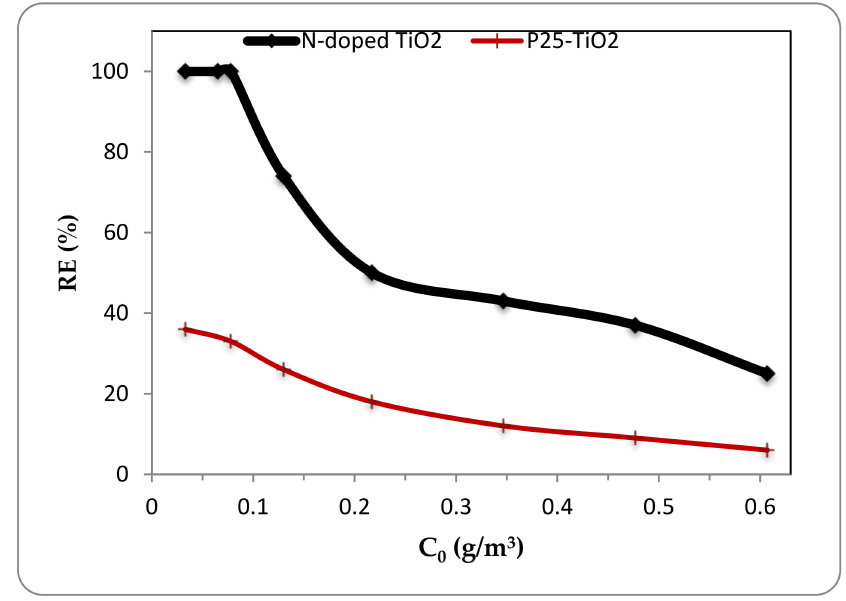
Figure 9. Effect of inlet concentration on removal efficiency at 3 min residence time under visible light irradiation for N-doped and pristine TiO 2